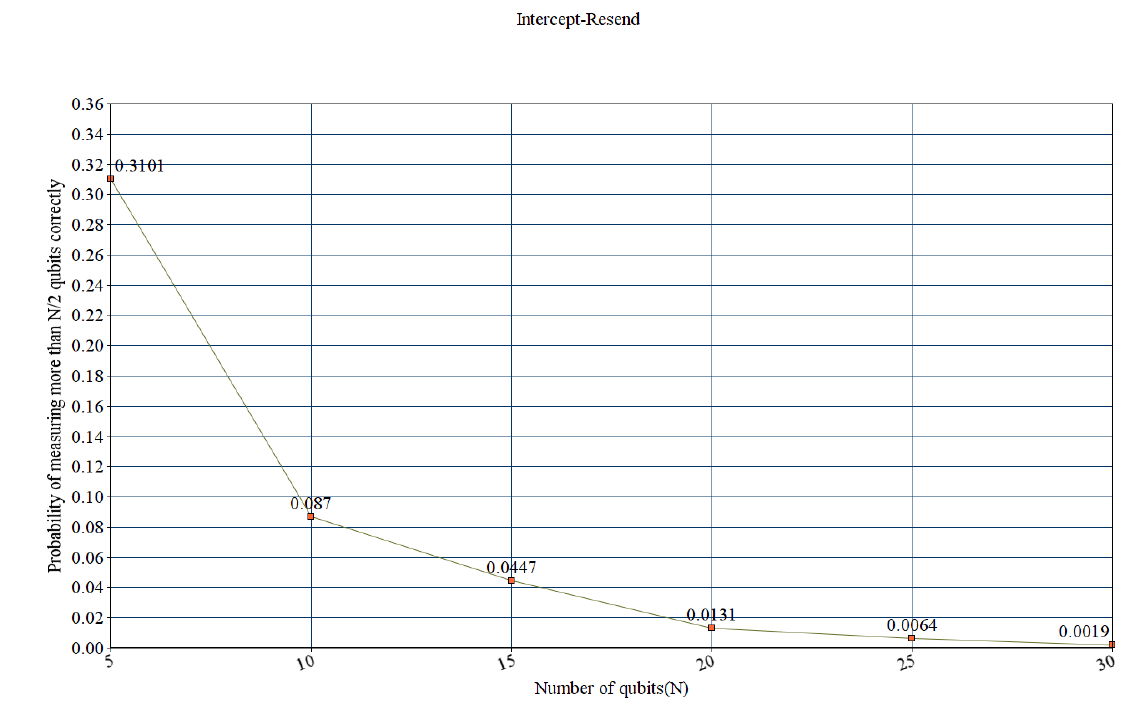
Figure 8. Probability that EVE measures more than half of the information correctly during Intercept Resend Attack.